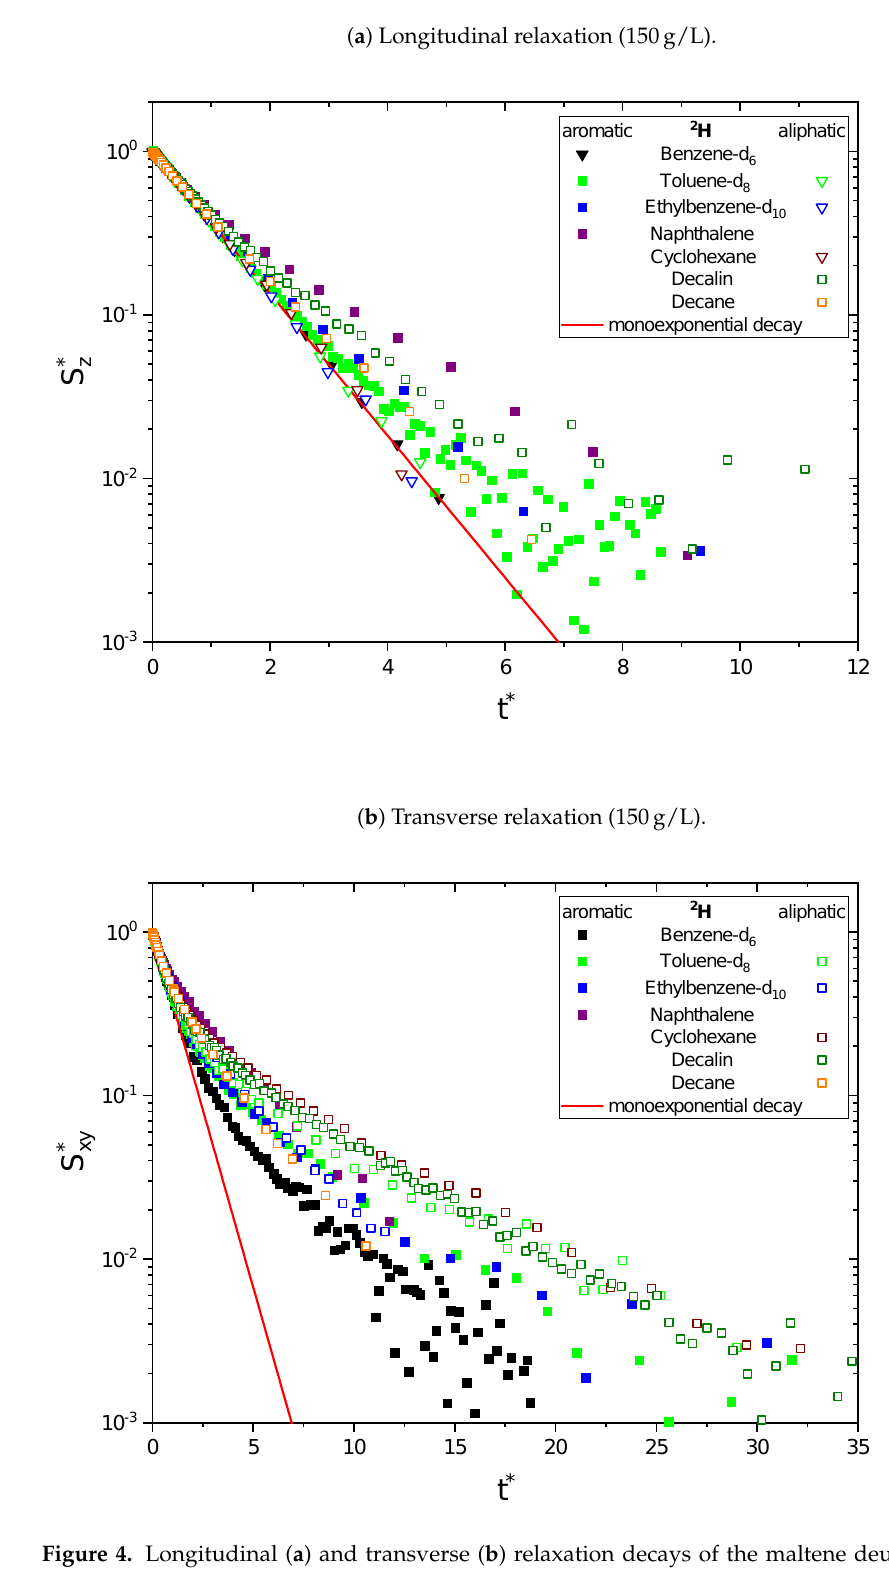
Figure 4. Longitudinal ( a ) and transverse ( b ) relaxation decays of the maltene deuterons in the asphaltenic solution, consisting of 95vol% benzene and 5vol% of the investigated deuterated maltene with additional 150g/L asphaltene. For a qualitative comparison, the time axis is rescaled (see − 1 ∗ = 0 (see Equation (12)) to reflect multiples of R 1,2 and the signal is normalized to unity at t Equations (13) and (14)). The needed parameters were obtained from a monoexponential ( (cid:79) ) or biexponential ( (cid:3) )